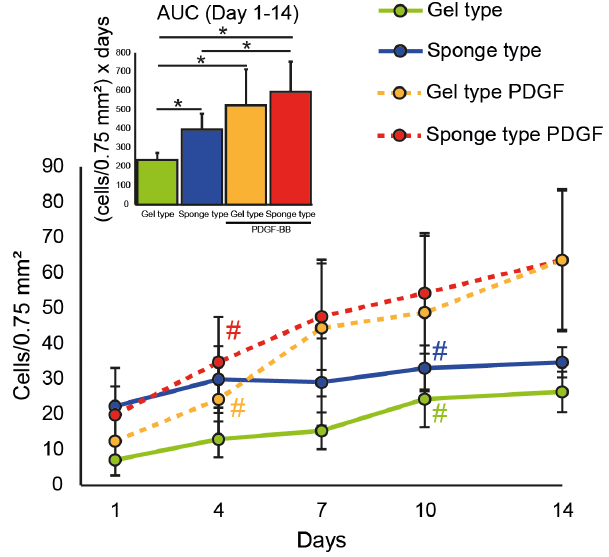
Figure 3. Cell numbers of human gingival fibroblasts in the gel type and the sponge type scaffolds. The number of human gingival fibroblasts in gel type and sponge type scaffolds with and without platelet-derived growth factor-BB (PDGF) was quantified and is presented as mean number of cells 6 standard deviation. Area under the curve (AUC) analysis was performed from 1 to 14 days (n=6–7 per group). Data were analyzed using analysis of variance (ANOVA) and Fisher’s protected least significant difference (PLSD) post hoc test. Significance (*, # ) was assigned at p , 0.05. The colored pound sign ( # ) indicates the first time a difference to day 1 was observed for the group of the corresponding color. The PDGF containing sponge type scaffold was different from the sponge type scaffold from day 7 to day 14.